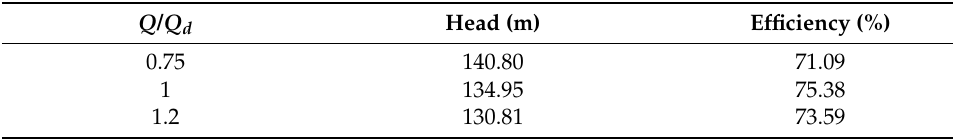
Table 4. Calculation results of pump performance.